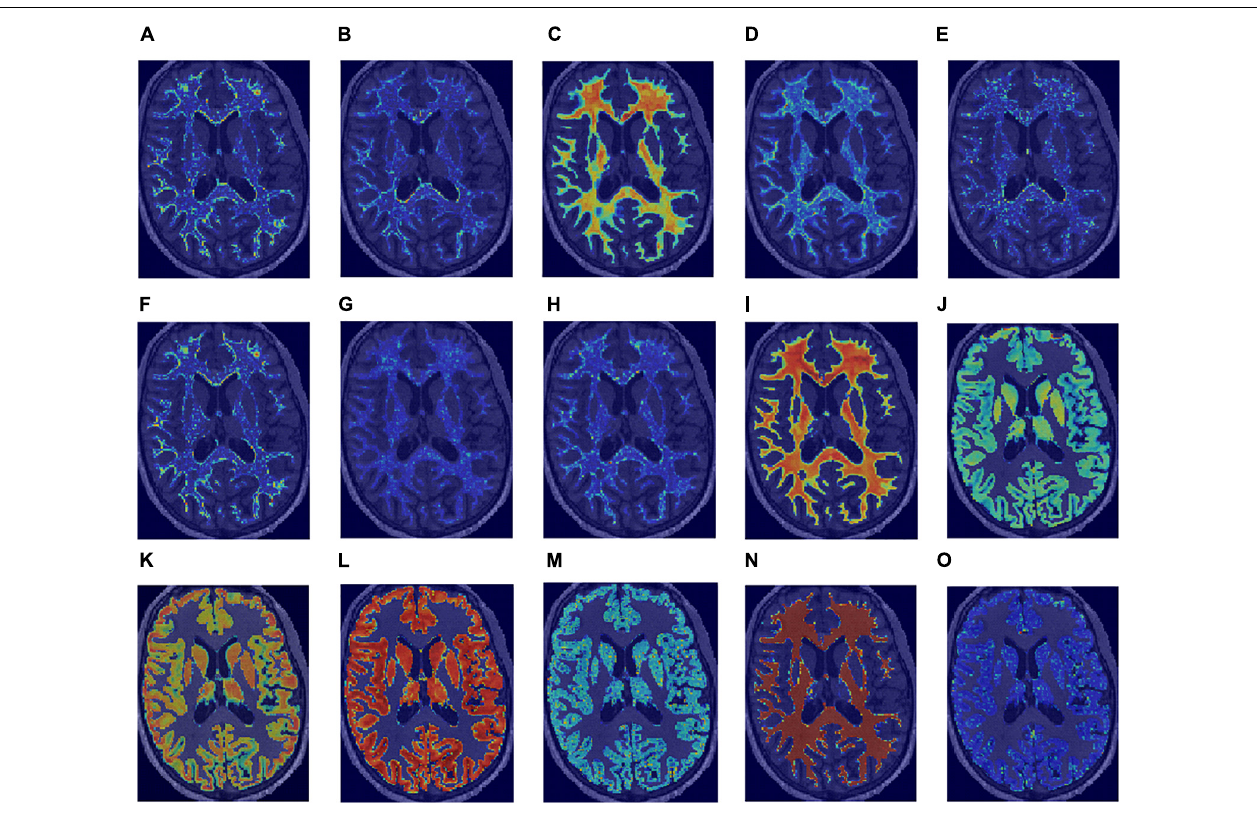
FIGURE 5 | Normalized saliency maps for the best selected features for each region of interest and image type highlight the areas with the highest feature values: (A) T1w GLCM cluster shade in WM, (B) PD first-order skewness in WM, (C) MT first-order minimum in WM, (D) R1 first-order kurtosis in WM, (E) R2* GLCM cluster shade in WM, (F) T1w GLCM cluster shade in NAWM, (G) PD GLDM large dependence high gray level emphasis in NAWM, (H) MT GLDM large dependence high gray level emphasis in NAWM, (I) R1 first-order 10-percentile in NAWM, (J) R2* GLCM Imc2 in NAWM, (K) T1w first-order 10-percentile in GM, (L) PD